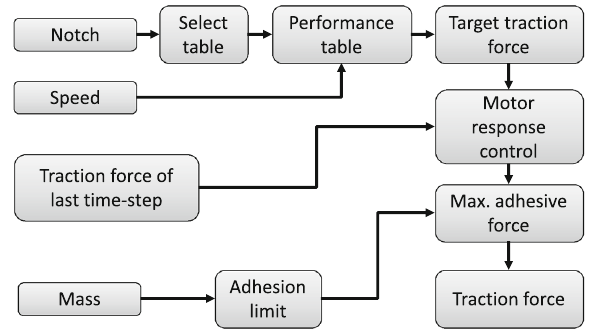
Fig. 1 1D locomotive model used for conventional LTD simulations